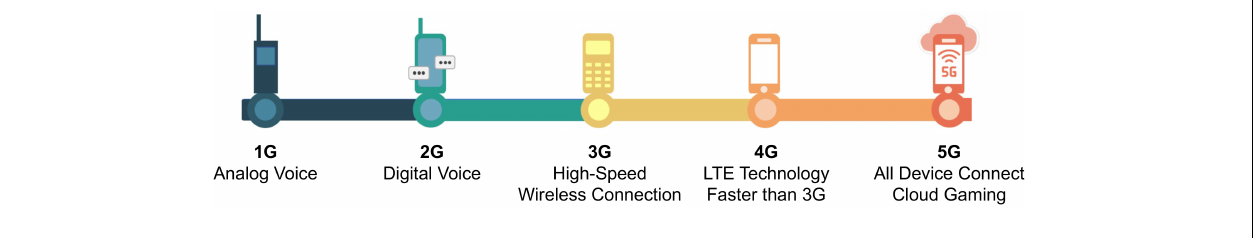
FIGURE 2 | Evolution of mobile generation from 1G to